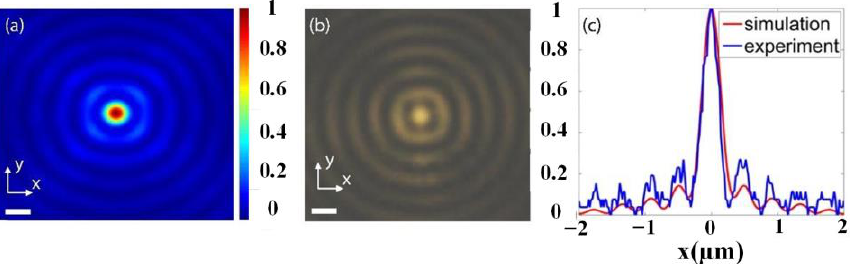
Figure 5. Light field intensity profiles on the transverse cross-section of the BB at λ d = 587 nm; ( a ) numerically simulated; ( b ) experimentally recorded; ( c ) intensity profiles of ( a ) and ( b ) along the x - axis.